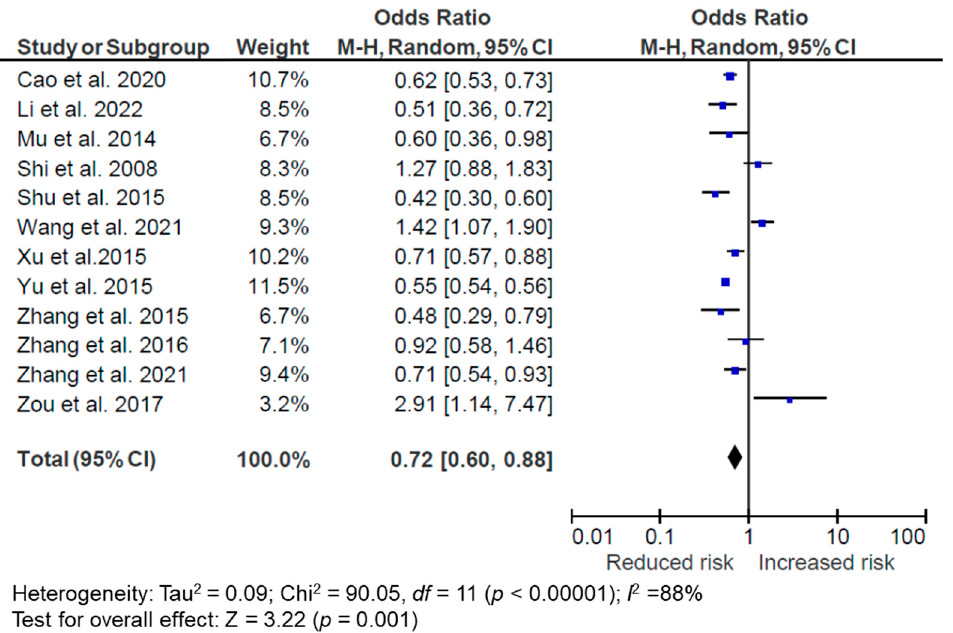
Figure 3. Forest plot of pooled odds ratios (ORs) with 95% confidence interval (CI) for the highest versus lowest quantile of the traditional dietary pattern for overweight/obesity [35,37,39–42,44,47– 50,54].